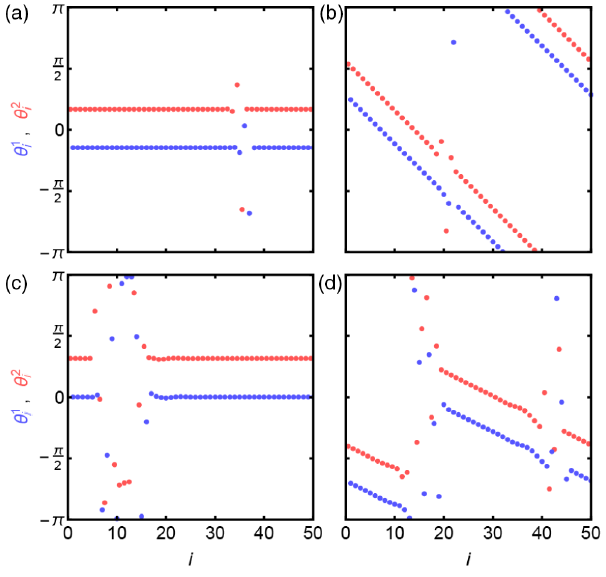
FIG. 5. Phase θ 1 ; 2 i vs index i for various partially locked chimera states. Oscillators with natural frequency − 1 = 2 are shown as blue dots, and oscillators with natural frequency 1 = 2 are shown as red dots. In the chimera states in (a) and (b), most oscillators are phase locked, but a small number of oscillators drift around point defects. Other chimera states are observed in (c) and (d) with one or more larger clusters of asynchronous oscillators. In all these cases, the structures are not fixed in space but move in time with an essentially constant velocity to the right or